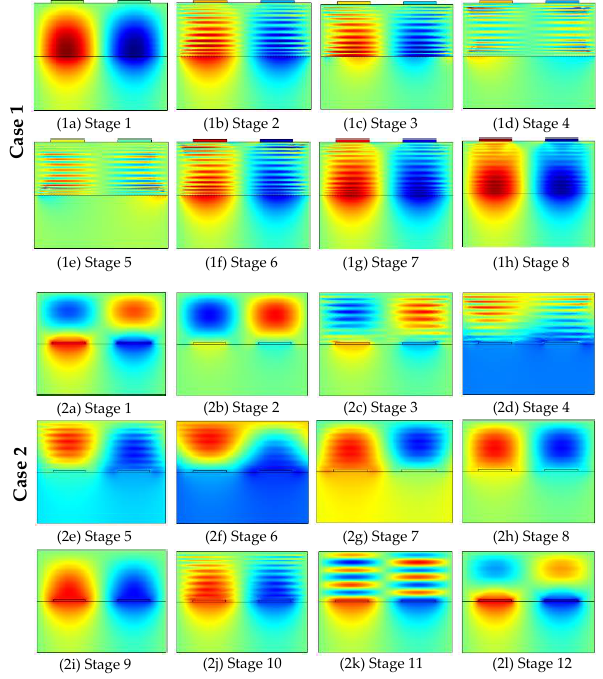
Figure 13. Potential oscillation period of the phonon piezoelectric device.